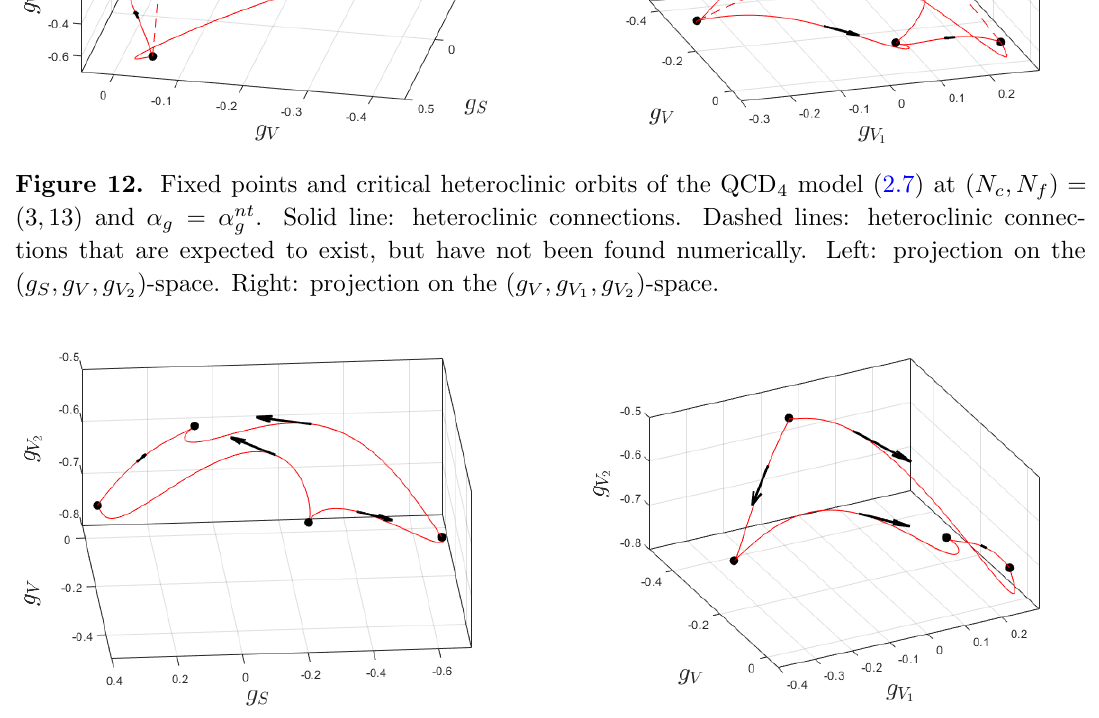
4 model (2.7) at ( N c ; N f ) = )-space. Right: projection on the 2